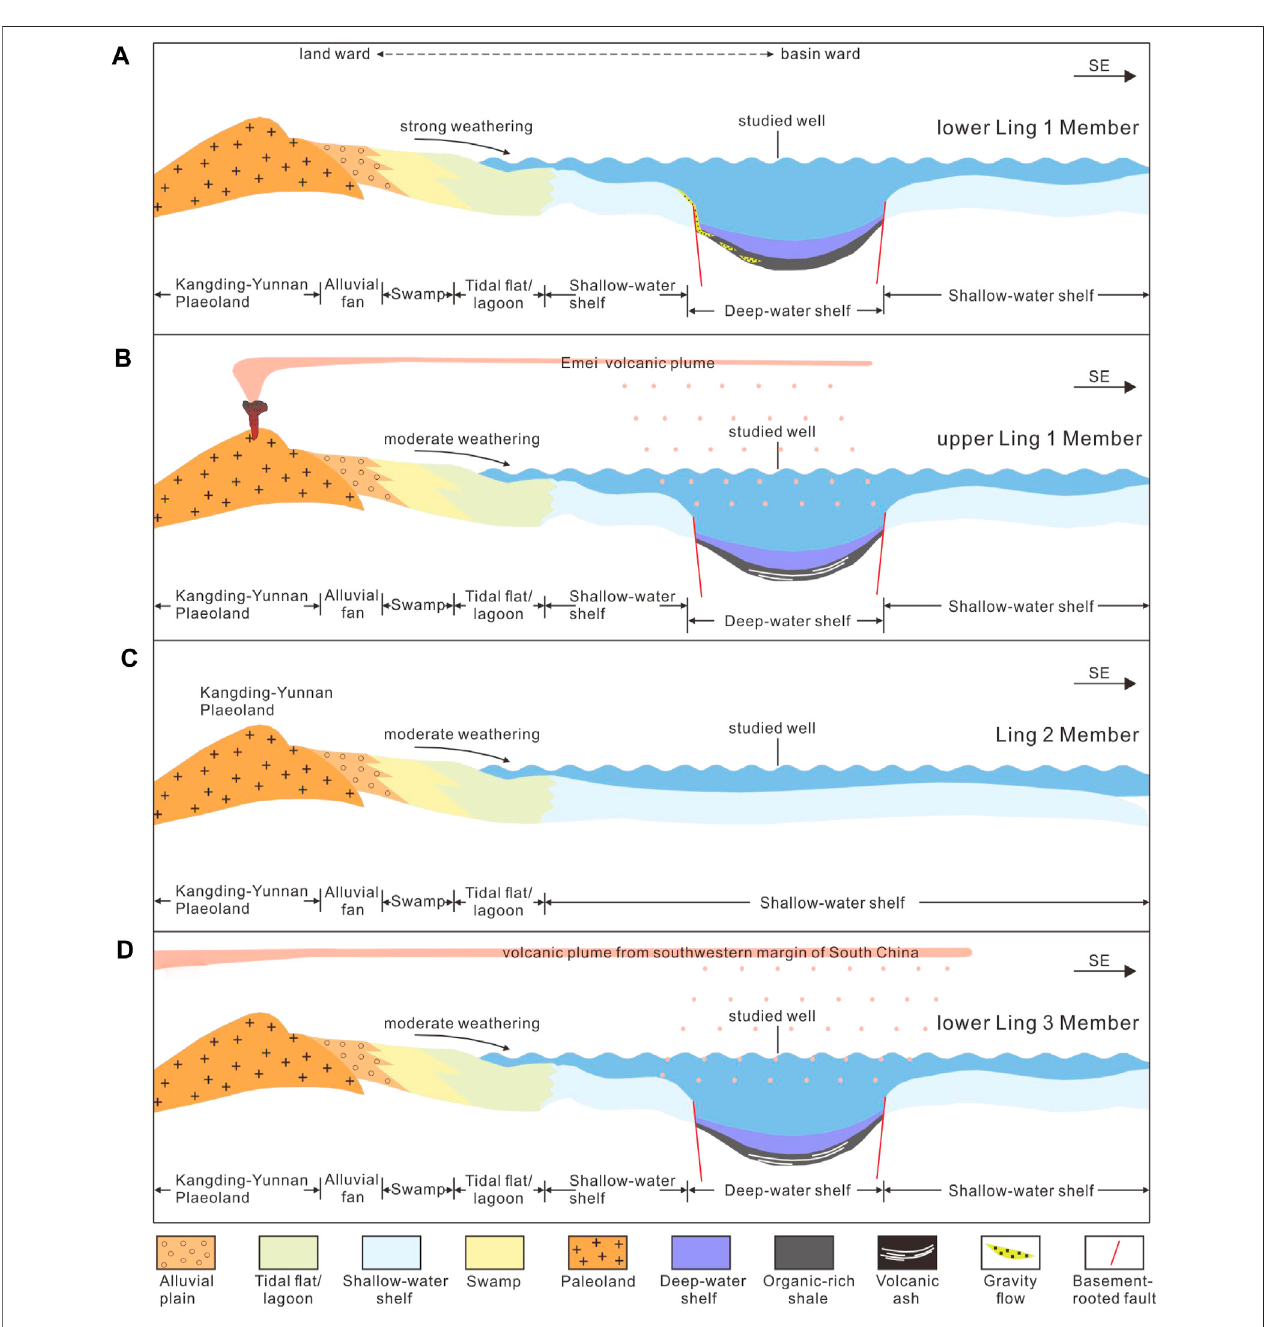
FIGURE12| ModeloftheenrichmentmechanismsoforganicmattersintheLinghaoFormationmarineorganic-richshale (A) lowerLing1member. (B) UpperLing 1 member. (C) Ling 2 Member. (D) Lower Ling 3 member.